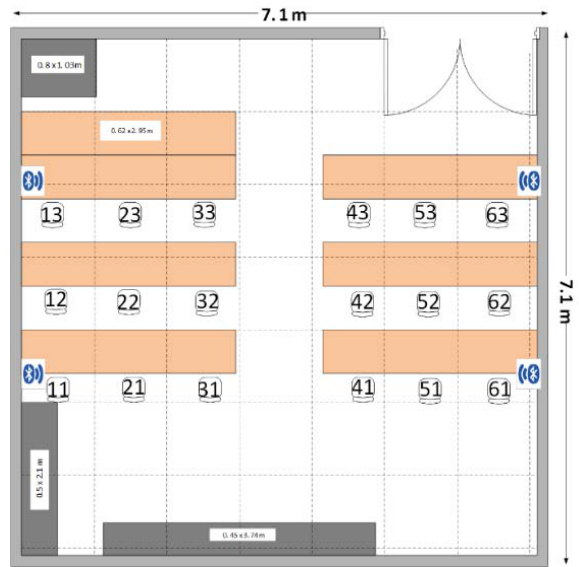
Figure 2. Test site for Bluetooth Low Energy (BLE) indoor positioning (Classroom type II) .